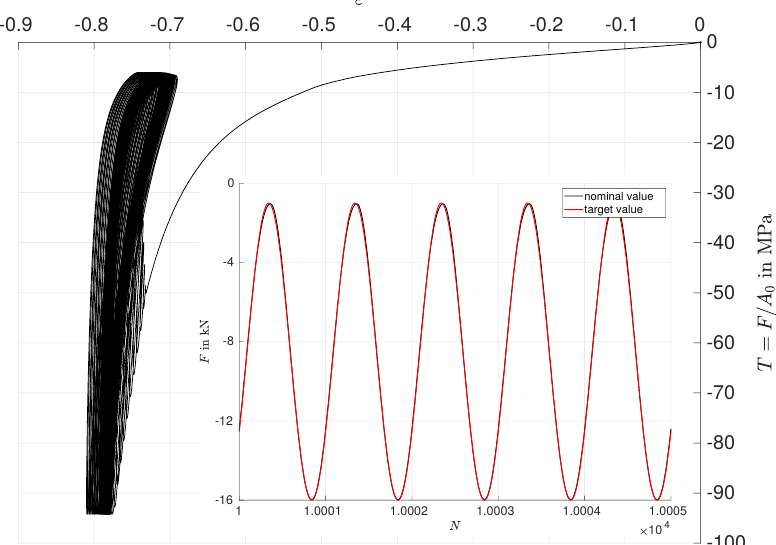
Figure 9. Stress–strain diagram for filled EPDM rubber (force-controlled test with a mean load of F = − 8.5 kN and an amplitude of ˆ F = 7.5